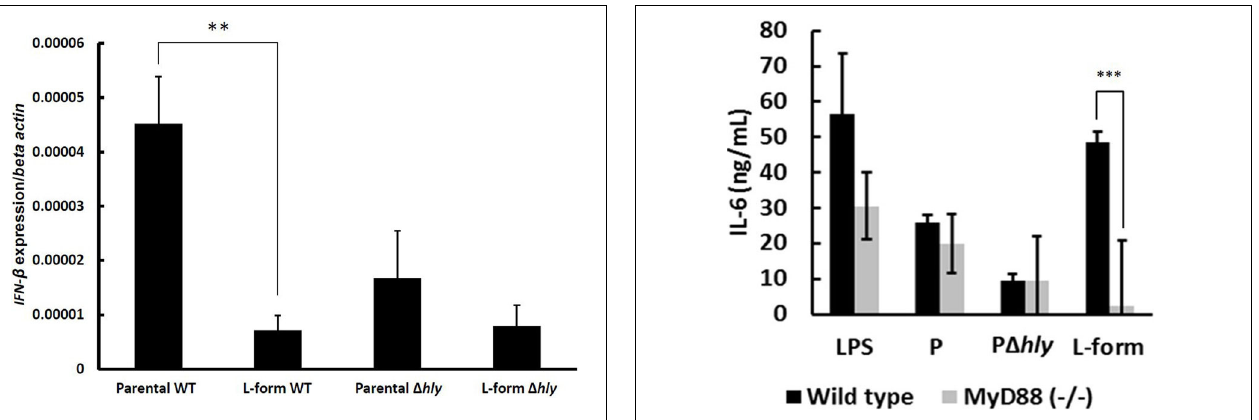
FIGURE 7 | IL-6 induction of wild type and MyD88-deficient DC challenged by LPS, parental (P), hly -deficient (P (cid:2) hly ), and L-form L. monocytogenes . Soft agar and medium controls were subtracted. The abrogated IL-6 response of DC challenged with L-forms indicates to an exclusively MyD88-dependent response, which suggests vacuolar localization of L-forms. Data represent means ± s.e.m. Statistical analysis was performed using the unpaired Student’s t -test: ∗∗∗ P < 0 .